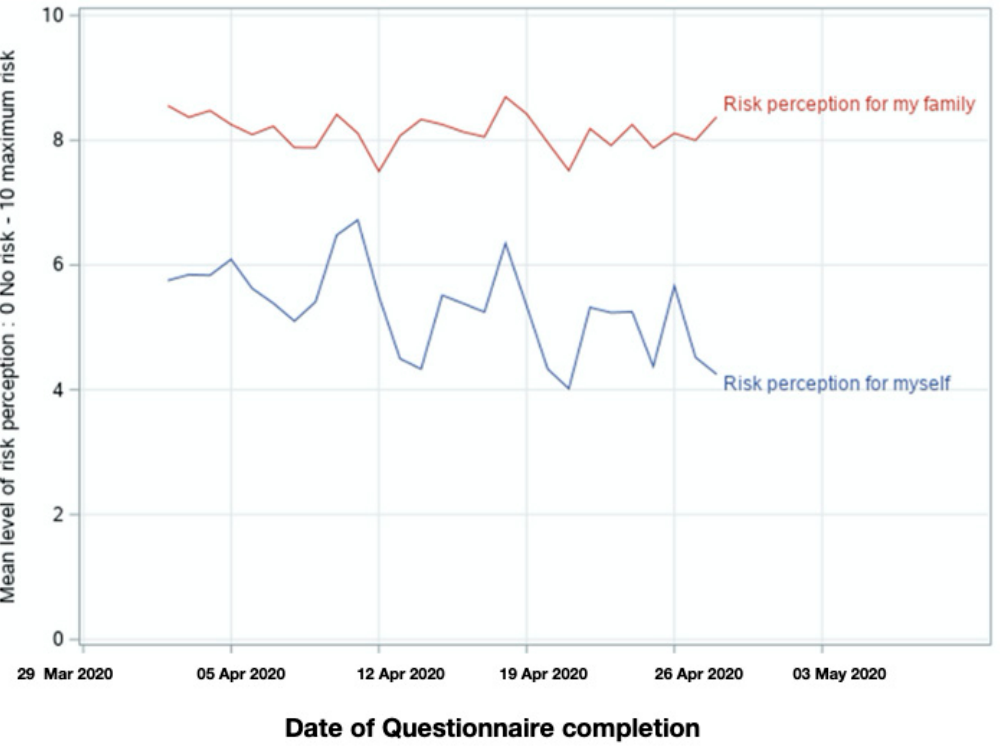
Figure 1. Variation of the mean level of participants’ risk perception for themselves and for their family. Risk perception significantly di ff ered based on demographic factors and disease knowledge in multivariate analyses. Using ordinal logistic regression, we found that higher disease knowledge score (adjusted odds ratio (aOR) 1.06, 95%CI 1.01–1.11), presence of chronic disease (aOR 2.31, 95%CI 1.82–2.93) and use of immunosuppressants (aOR 2.53, 95%CI 1.67–3.87) were associated with a higher risk perception of COVID-19 infection but not age nor gender (Table